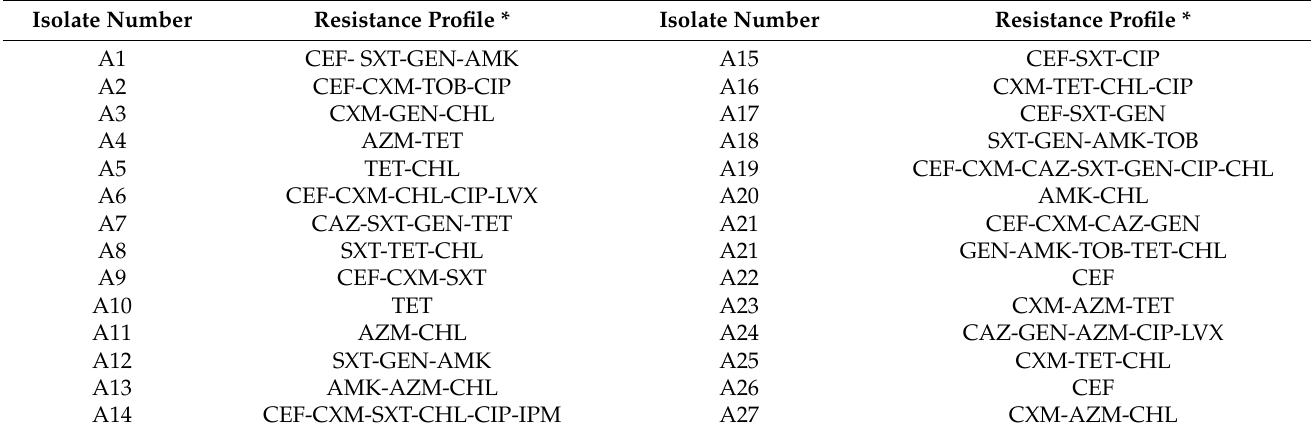
Table 2. Antimicrobial resistance profile of A. baumannii isolates. Isolate Number Resistance Profile